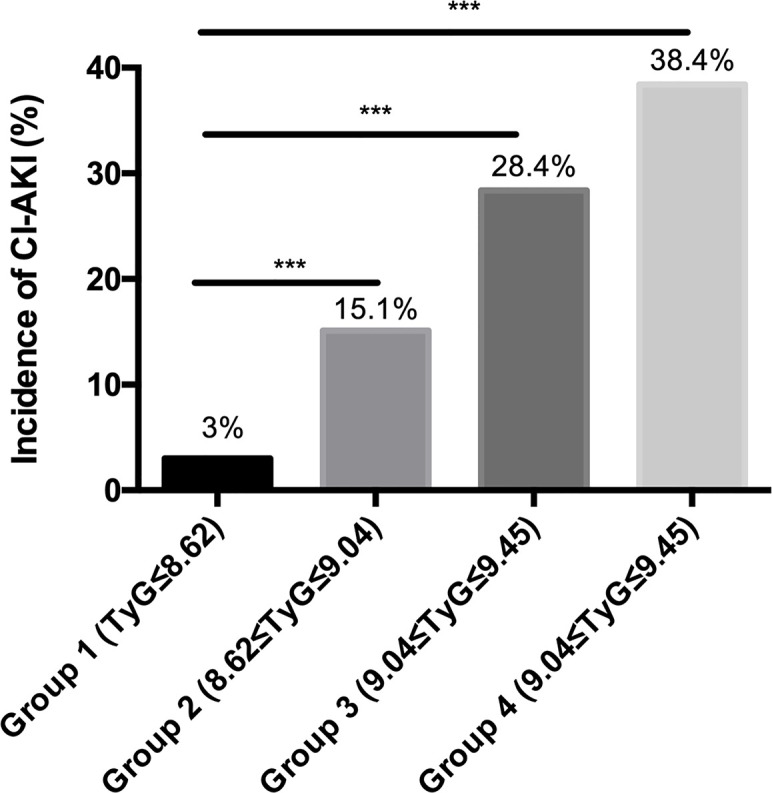
The incidence of CI-AKI in different TyG groups. *** represents P < 0.001.